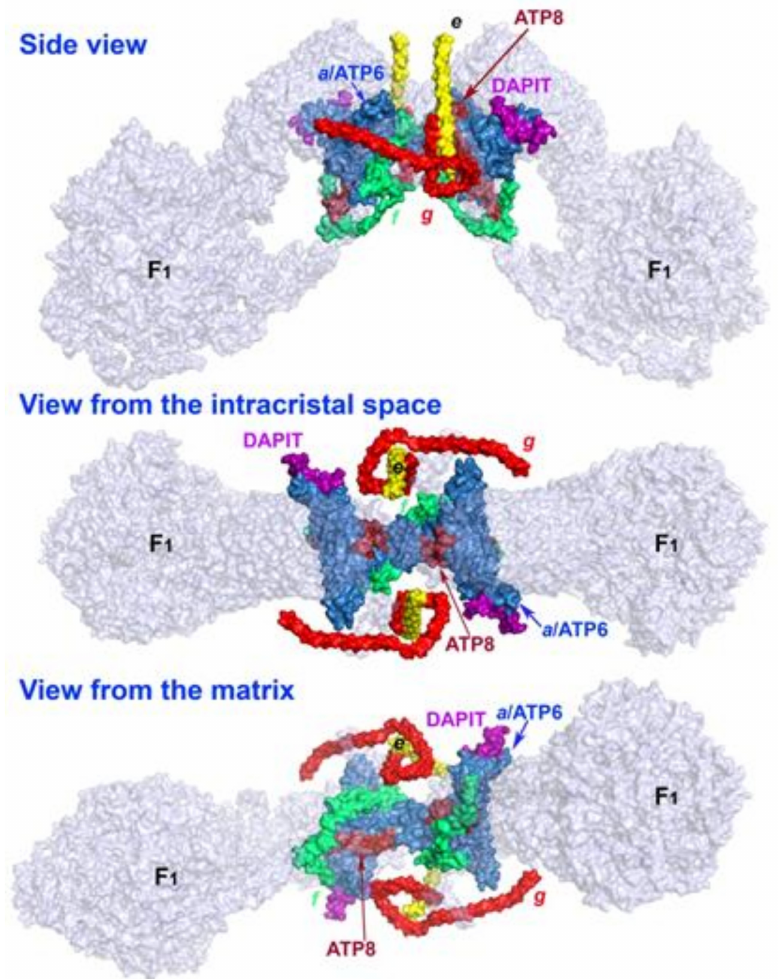
Figure 1. DAPIT location within the ATP synthase structure. Neighbor subunits of DAPIT are shown within the structure of membrane F O -sector of the ATP synthase. DAPIT and the surrounding subunits are depicted in color, the remaining subunits are transparent. A side view represents a transversal section of the crista rim; a “bottom” view is from the intracristal space directly viewing the inner sharpest IMM bend, when one considers the F 1 moiety being positioned at the top. A top view is also the top view for the crista rim and the top of the sharp edge of the IMM bent. The ATP synthase structure was derived from the atomic model for the dimeric F O region of mitochondrial ATP synthase published by Guo H. et al. [37], pdb code 6b8 h. The structure was visualized using the PyMOL Molecular Graphics System, Version 1.8 Schrödinger,